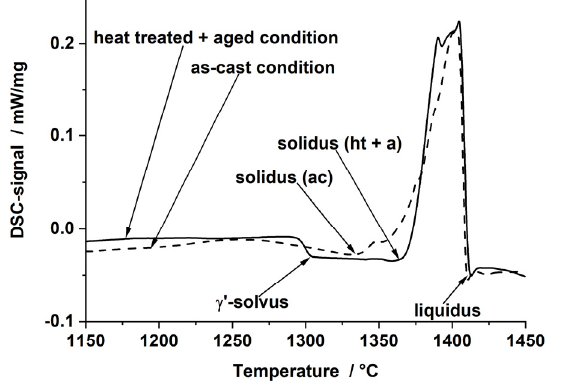
Figure 1. Example for the determination of phase transformation temperatures based on DSC measurements. The figure shows the DSC response of the alloy ERBO/19 in the as-cast (ac) and the heat treated + aged (ht + a) state. The arrows indicate the temperatures of phase transformations.